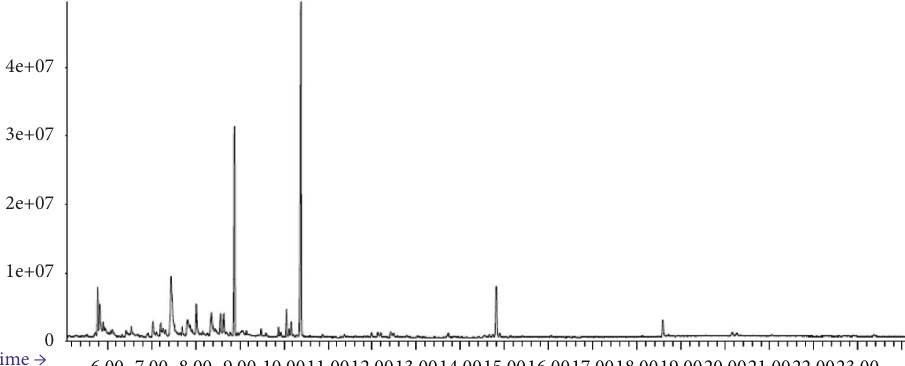
Figure 3: Chromatogram of Matricaria recutita L. essential oil.